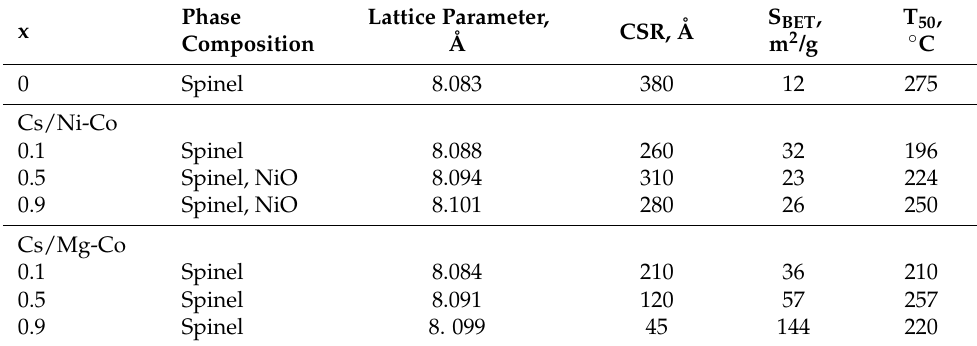
Table 1. Physicochemical characteristics of the Cs/Me x Co 3-x O 4 (Me: Ni or Mg, x = 0–0.9) samples and the half-transformation temperature (T 50 ).